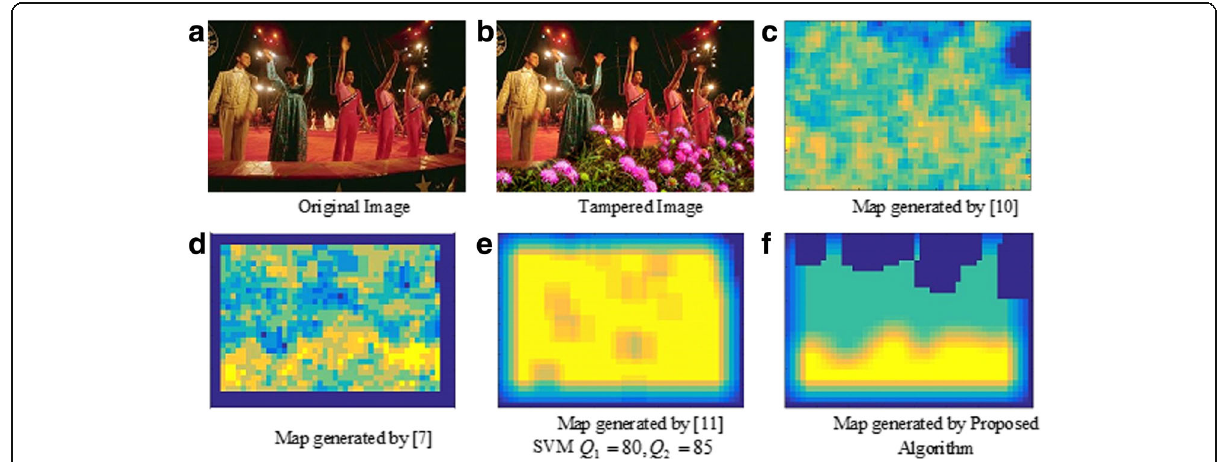
Fig. 5 a – f Tampering localization in scene images, CASIA V.2 tampered image